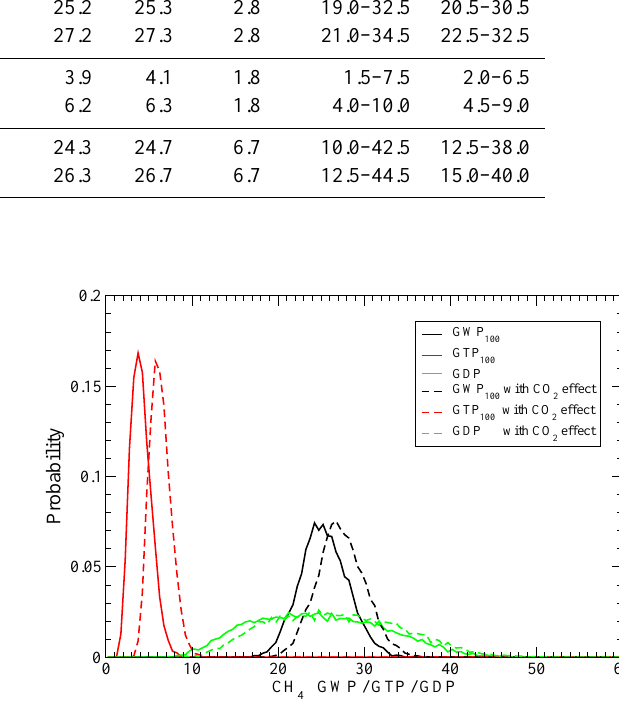
Fig. 4. Probability distribution function of the methane CO 2 -equivalence (GWP with 100-yr time horizon, GTP with 100-yr time horizon, and GDP) obtained from randomly perturbing the input pa- rameters with the PDFs specified in Table 1. The dashed lines ac- count for the CH 4 conversion to CO 2